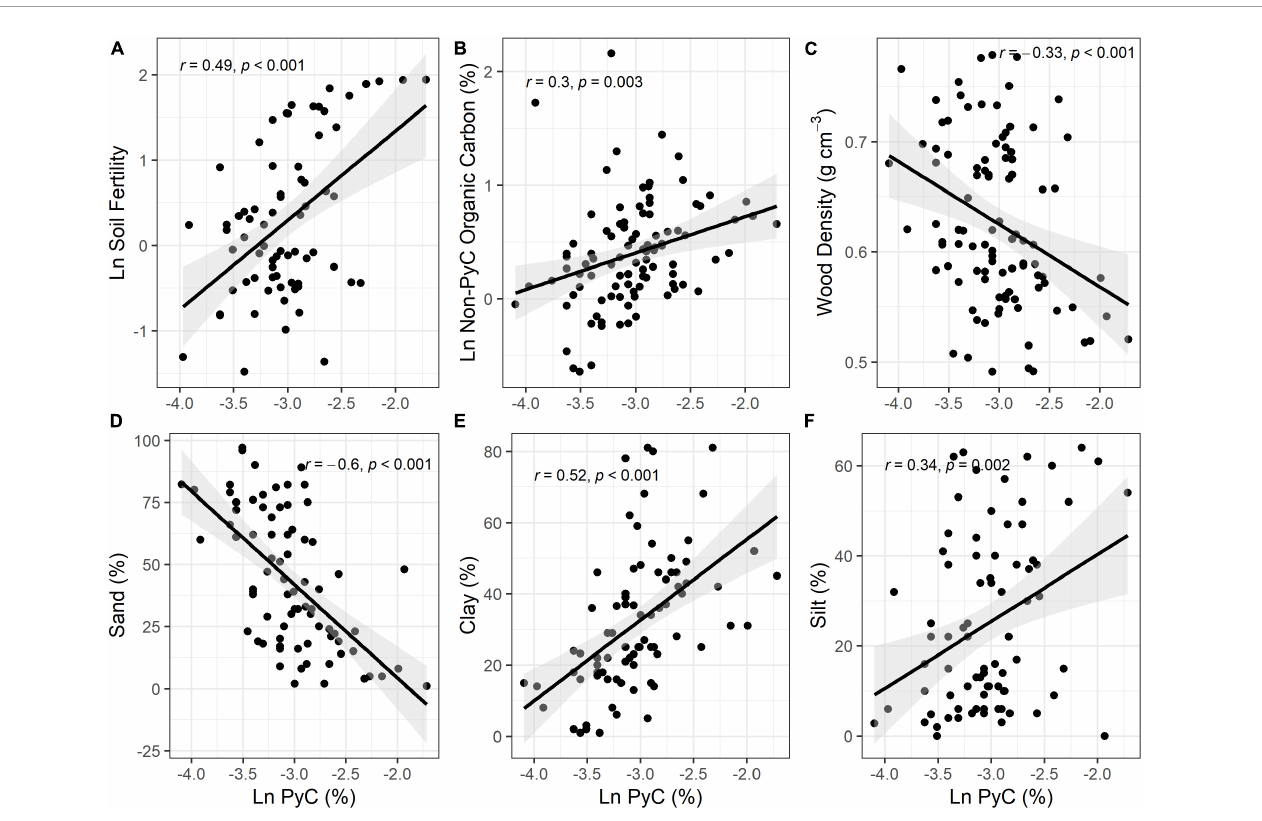
FIGURE3 Relationship between soil PyC, physicochemical soil properties and wood density. (A) Soil fertility (log scale), (B) organic carbon (log scale) (%), (C) wood density (g cm - 3 ), (D) sand (%), (E) clay (%), (F) silt (%). Shading denotes 95% confidence intervals of the linear models. Soil PyC is log transformed.